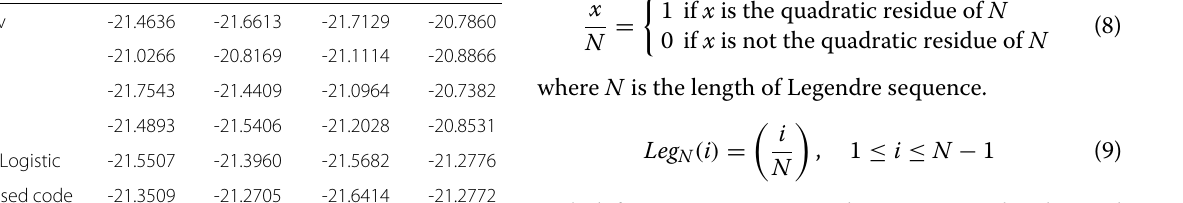
Table 1 Sidelobe peak value of auto-correlation and cross-correlation for six chaotic codes (dB) Ranging codes